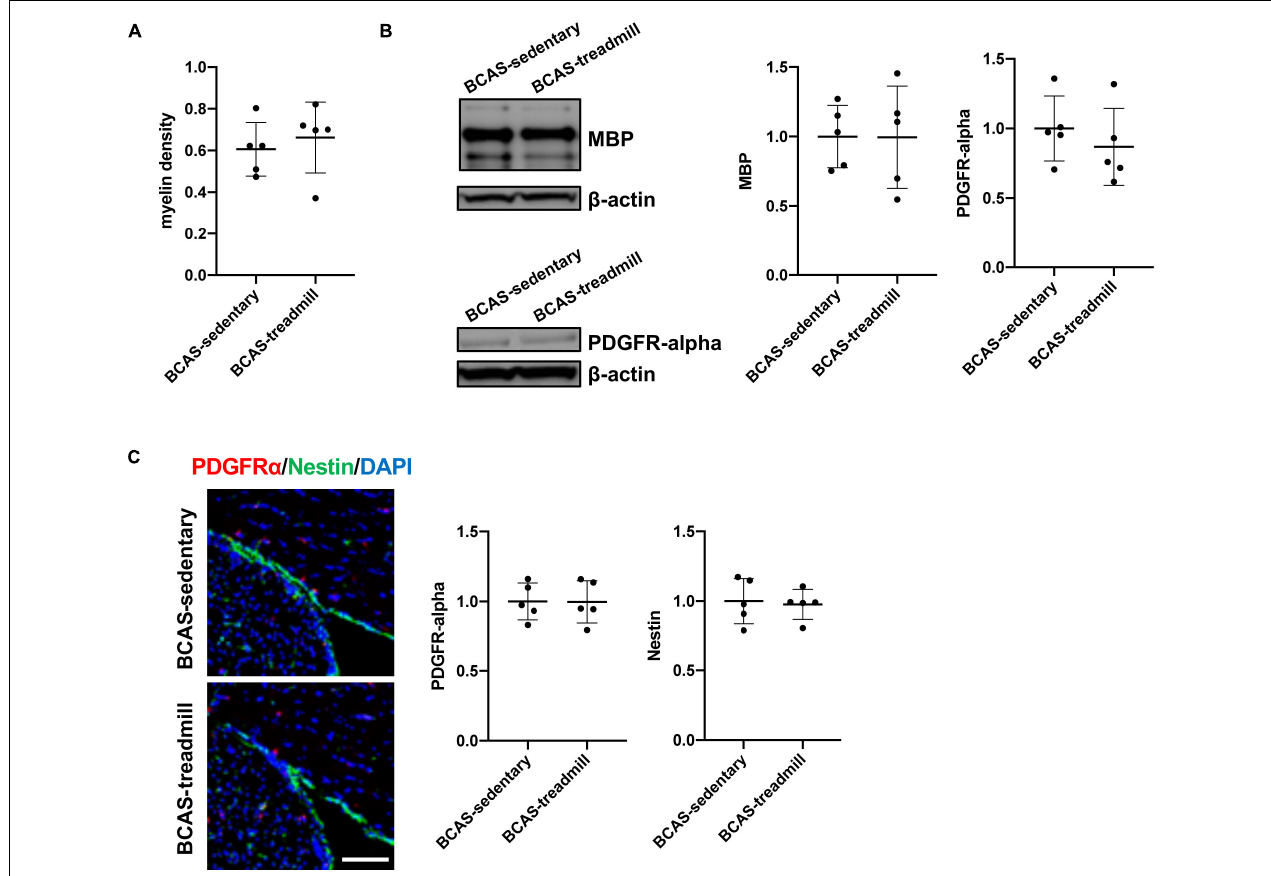
FIGURE 4 | (A) Result of myelin density of the corpus callosum, assessed by fluoromyelin staining. Myelin density was calculated based on the intensity of age-matched male C57/BL6J mice (average of 5 mice). There was no significant difference in myelin density between the 2 groups (BCAS/Sedentary vs. BCAS/Treadmill). Data are expressed as mean ± SD. (B) Result of MBP and PDGFR α western blot using samples from the corpus callosum region. Data are expressed as mean ± SD. (C) Immunohistochemistry showed that there were no significant differences in both the intensity of PDGFR α -positive cells and the intensity of Nestin-positive cells within the SVZ region. Data are expressed as mean ±